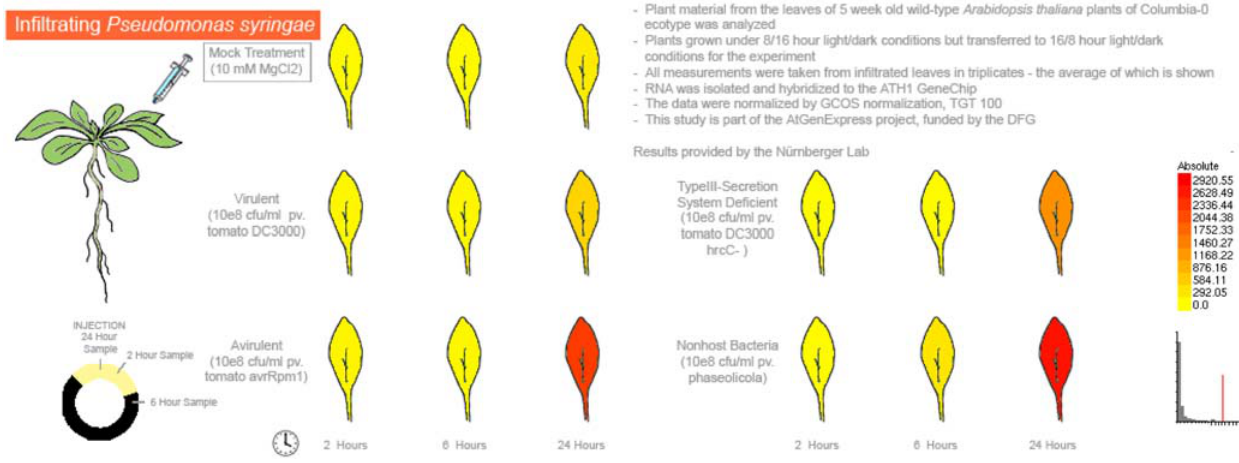
Figure 7. A section of the Arabidopsis eFP Browser Biotic Stress output. Induction of a pathogen-inducible gene, PR1 , At2g14610, upon Pseudomonas syringae attack, is clearly evident 24 hours after inoculation.